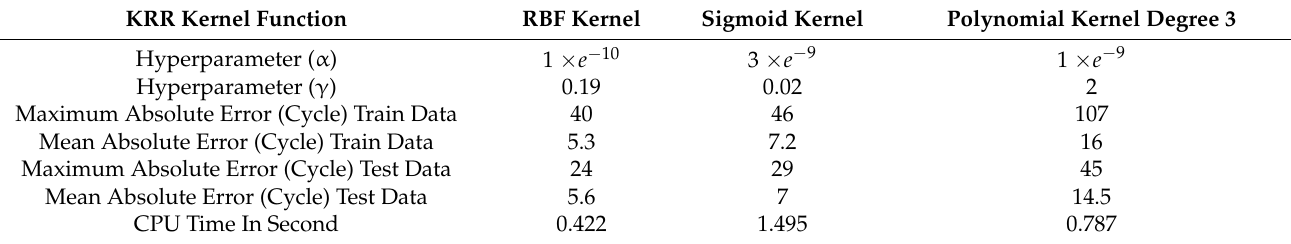
Table 17. Comparison results of FEM and KRR models on 1296 training datasets.